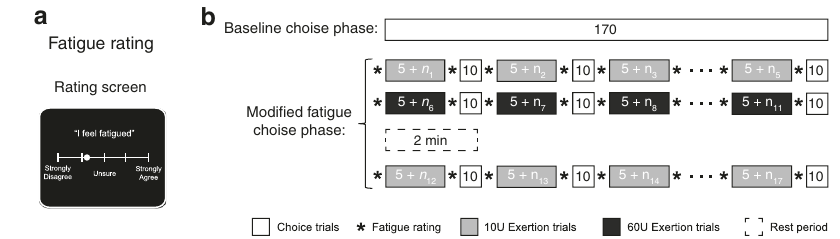
Fig. 5 Experimental Design of Control Experiment 2. a At the beginning and end of each exertion block, participants were queried on their level of agreement ( “ Strongly disagree ” , “ Somewhat disagree ” , “ Unsure ” , “ Somewhat agree ” , “ Strongly agree ” ) with the statement “ I feel fatigued ” . Participants were free to select anywhere on the scale (not just the indicated points), and there was no time constraint for them to select their rating. b Experiment schedule. The control experiment was divided into baseline and modi fi ed fatigue choice phases. The baseline choice phase consisted of the same 170 effort-based choices used in the main experiment. Following the baseline choice phase, participants performed the modi fi ed fatigue choice phase, in which they alternated between exertion trials and choice trials. The modi fi ed fatigue choice phase began with participants alternating between low effort exertions (10U; light gray) and blocks of choice trials (white). Following this sequence of exertion/choice, participants alternated between high